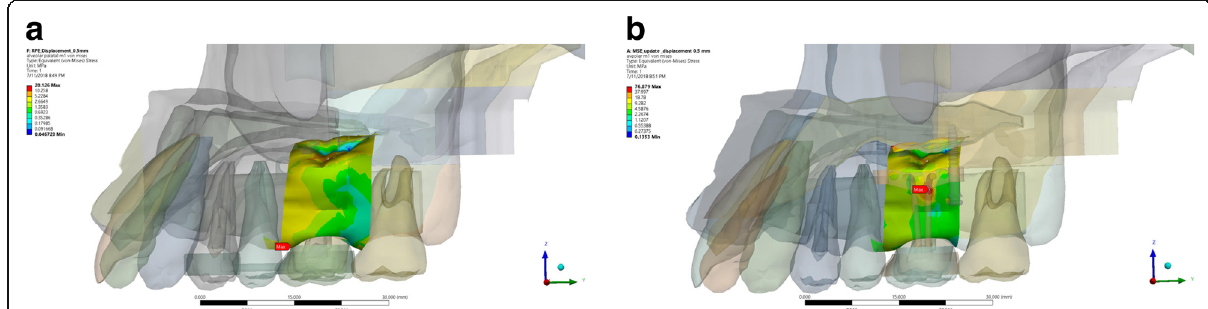
Fig. 2 The von Mises stress distribution on the palatal alveolar bone of upper first molar in the expansion simulation using ( a ) RME, and ( b ) MSE